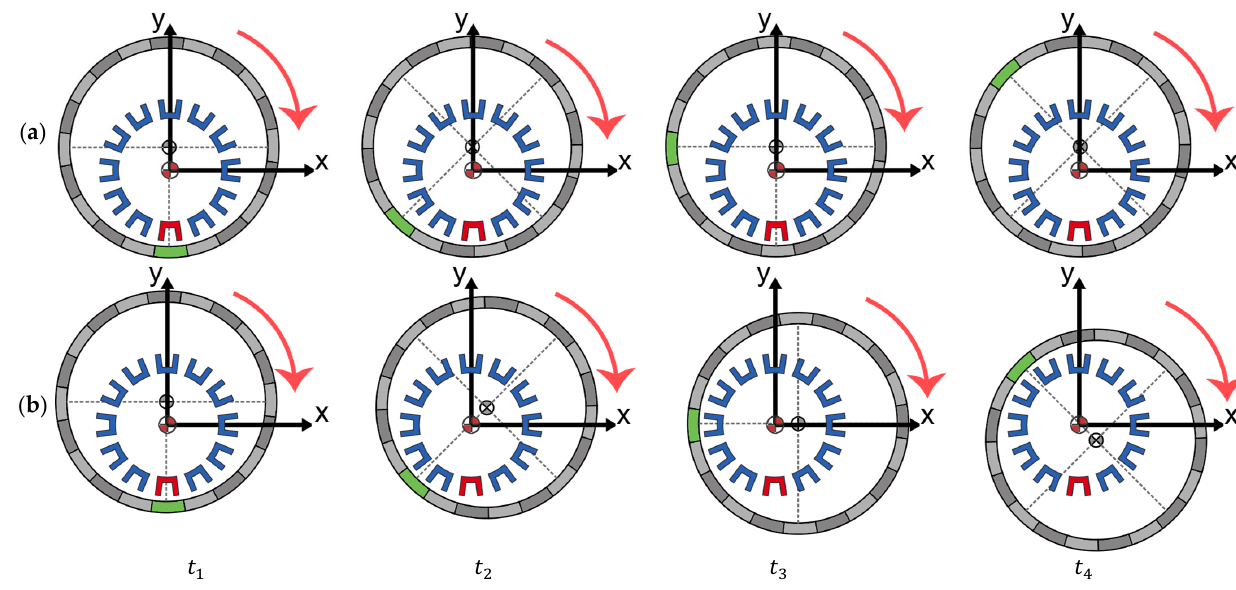
Figure 3. Representation of eccentricity types depending on its dynamics: ( a ) SE, in which the position of the minimum airgap is fixed, ( b ) DE, in which the position of the minimum airgap changes as the rotor structure rotates. Four arbitrary time instants are represented in the figure.